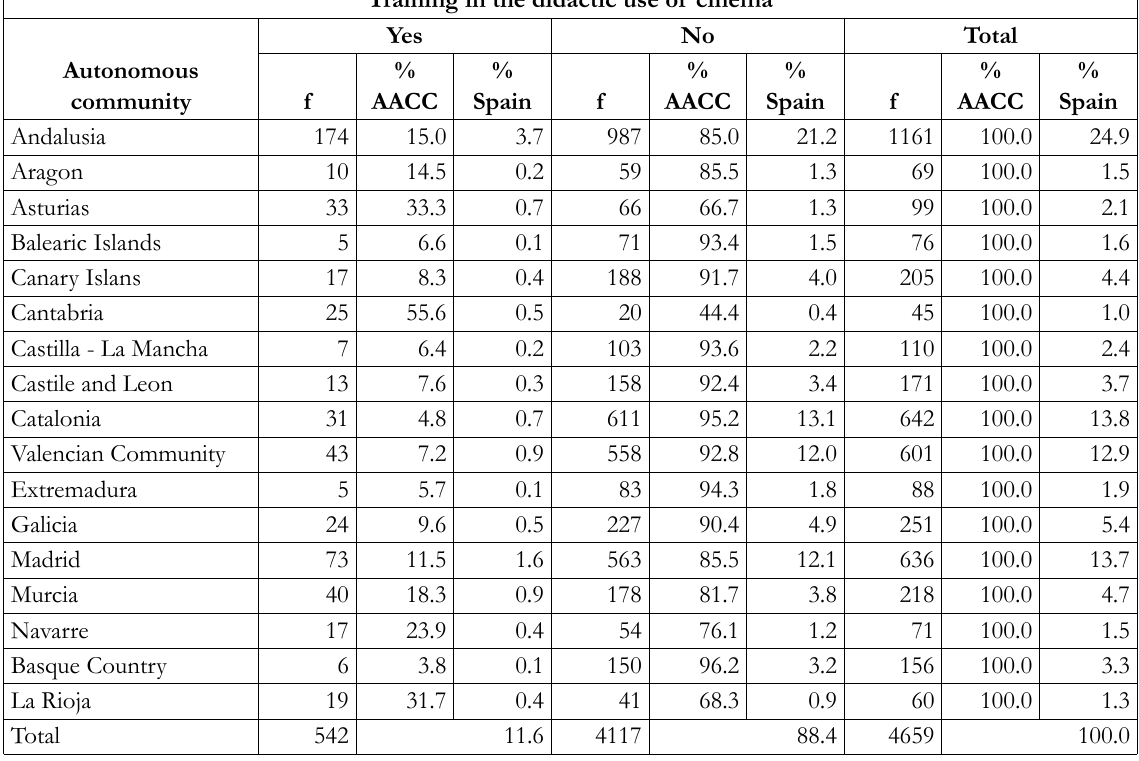
Table 2. Percentages and frequencies of training received by Teacher